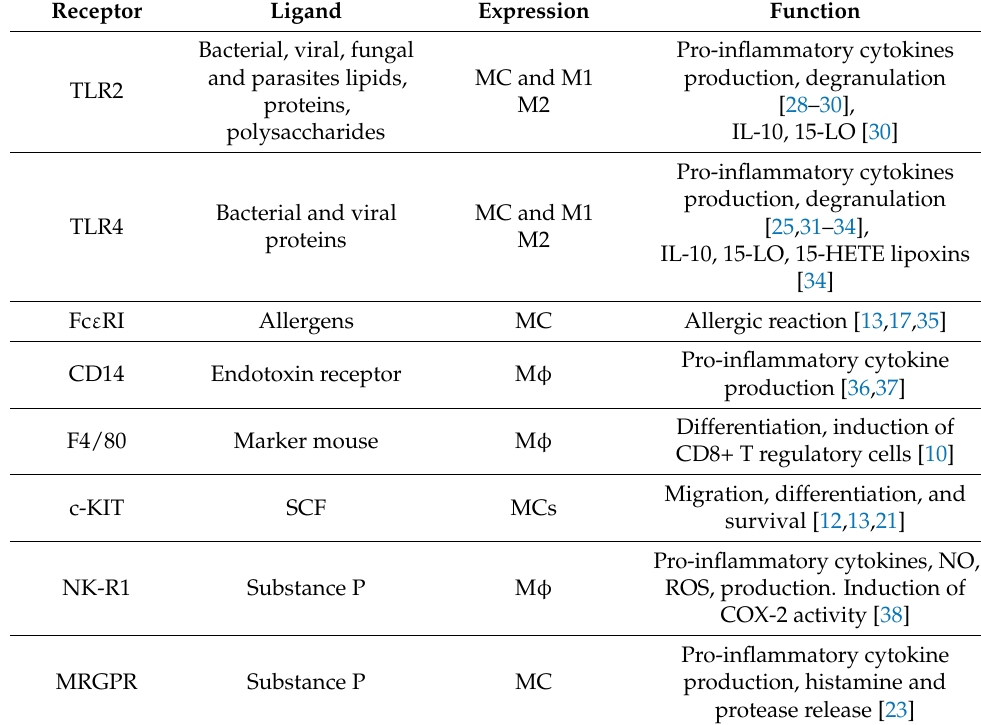
Table 1. Schematic description of the MC and M φ receptors, ligands, and functions mentioned in this